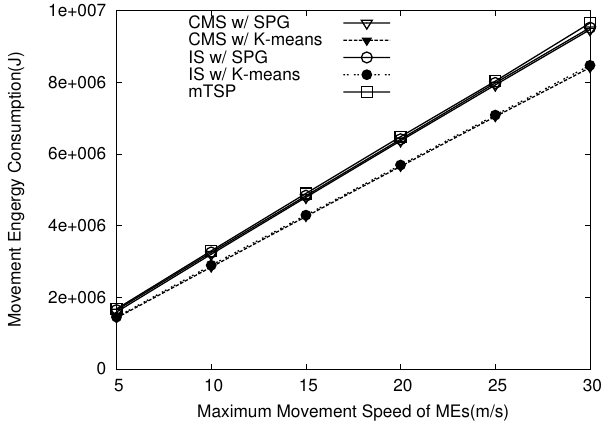
Figure 13. Effects of movement speed on energy consumption.